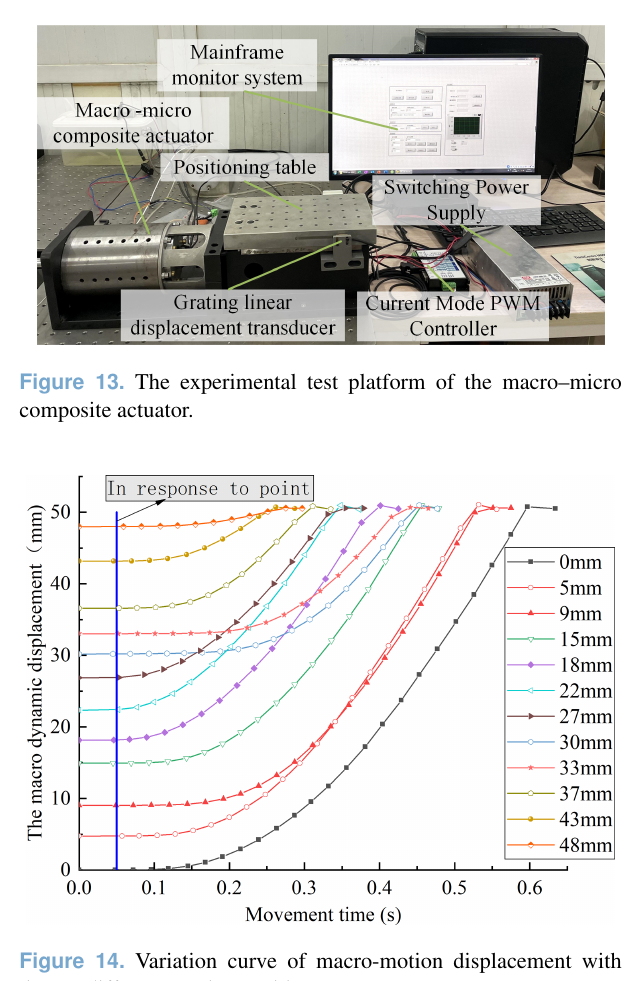
Figure 14. Variation curve of macro-motion displacement with time at different starting positions.